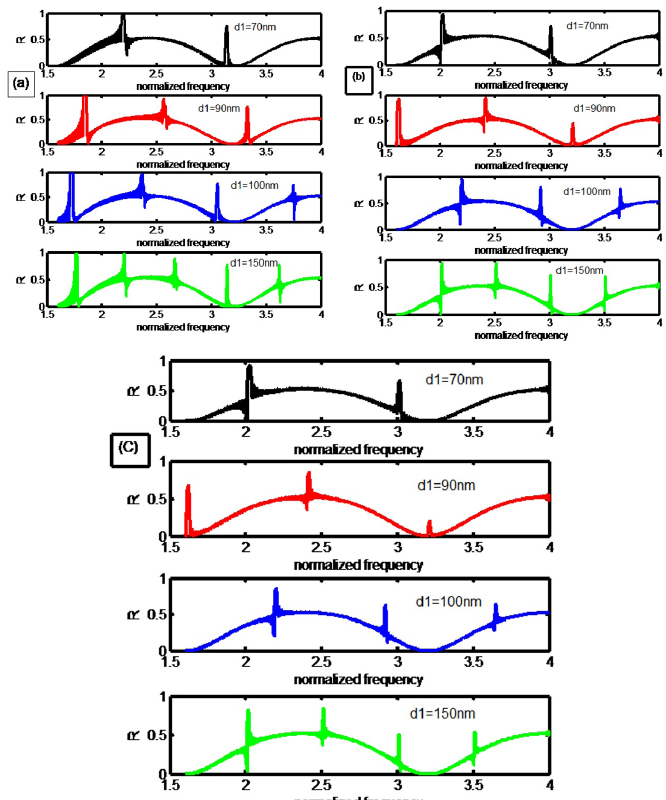
Figure 5. Reflectance spectra versus normalized frequency of the three periodic superconducting PC and for different values of thicknesses d 1